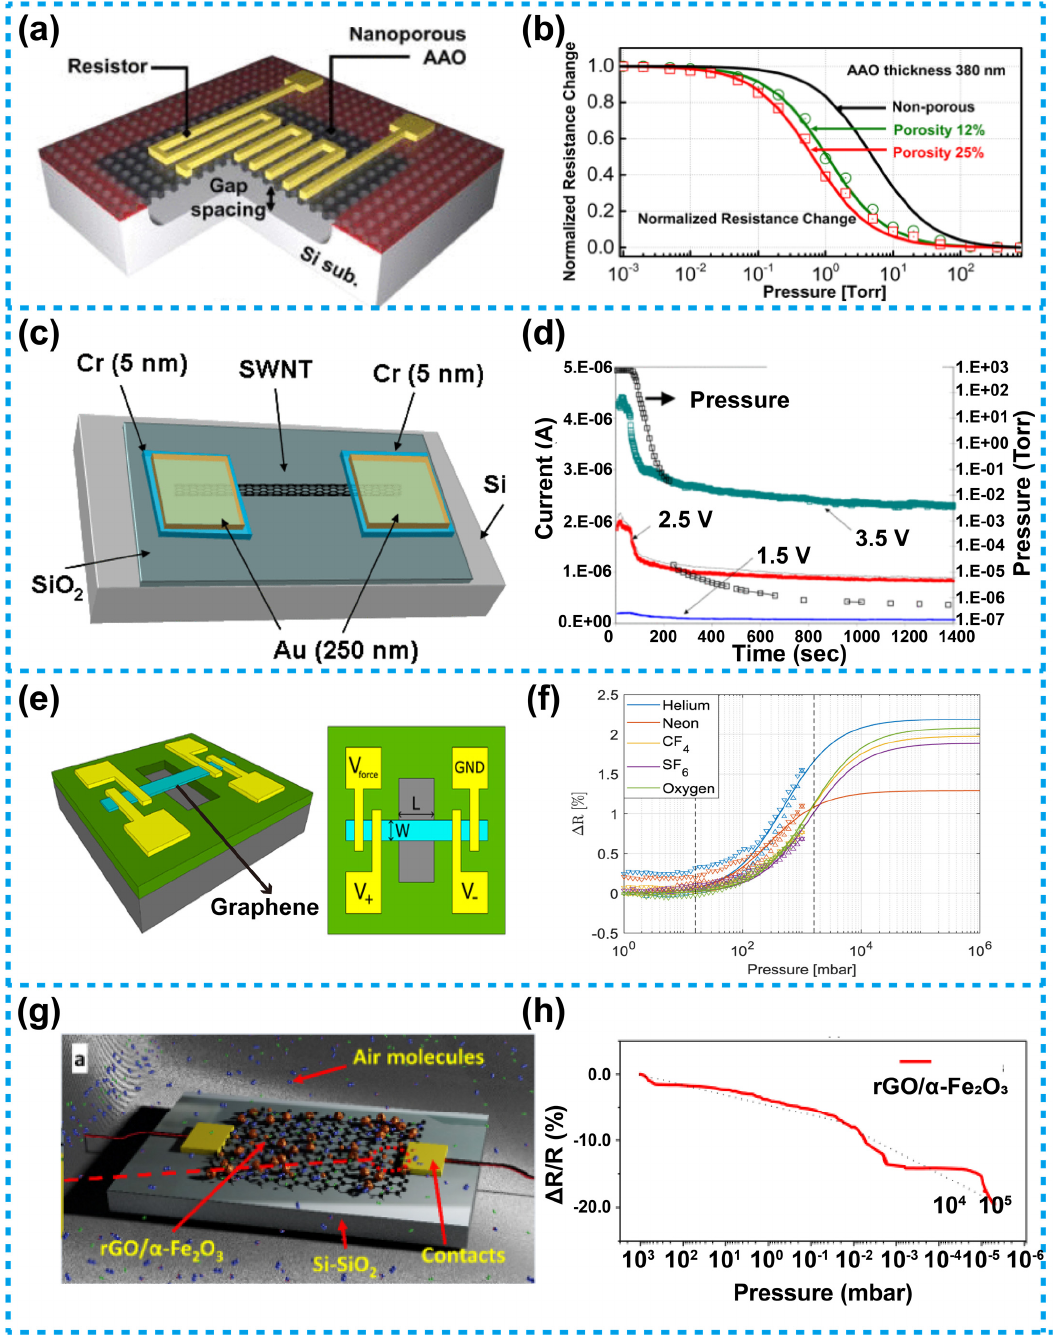
Figure 8. A Pirani sensor based on functional materials. ( a ) Schematic of the nanoporous AAO-based Pirani sensor [99]. ( b ) Normalized resistance of the sensor versus pressure, with a 380 nm thick AAO membrane, the curve shifts to the left, indicating a better ability to detect low pressure. ( c ) Schematic of a Pirani sensor based on SWNT [100]. ( d ) Dynamic pressure response of device in ( c ), the sensitive range reaches 10 − 6 to 760 Torr (about 10 − 4 to 10 5 Pa). ( e ) Schematic of a sheet graphene-based Pirani sensor [103]. ( f ) Schematic diagram of resistance variation rate of the suspended graphene versus pressure in different gas circumstances. ( g ) Schematic and principle of Pirani sensors based on rGO- α Fe 2 O 3 [104]. ( h ) Resistance variation rate of the device versus pressure, the sensitive range was about 4 × 10 − 6 to 10 3 mBar (4 × 10 − 4 to 10 5 Pa, 1 mbar = 100